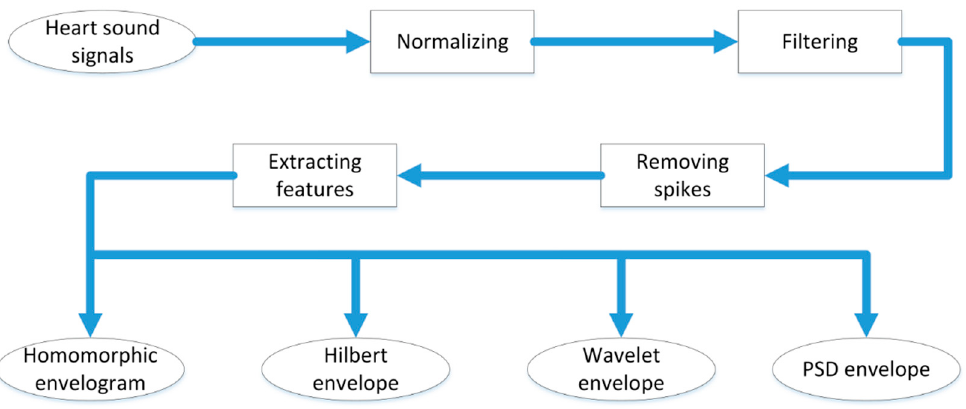
Figure 3. Diagram of the preprocessing method: normalization, filtering, and feature extraction.